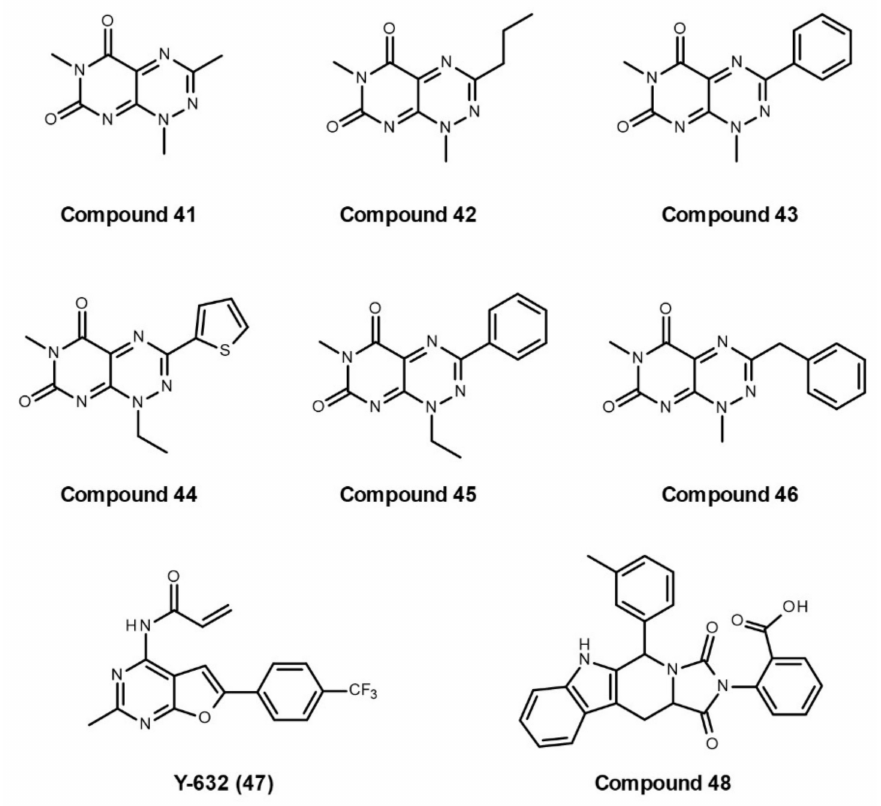
Figure 8. Developed small molecules with the ability to disrupt Hsp90–Hop